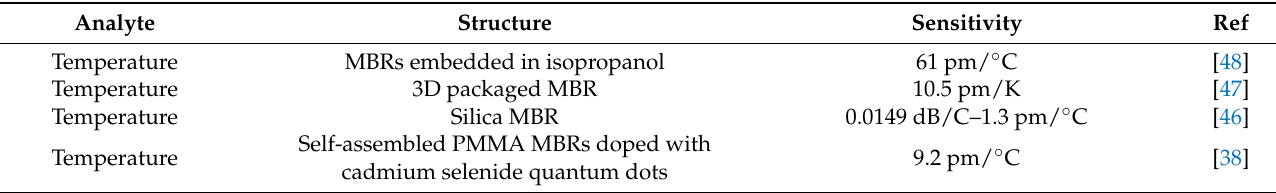
Table 2. Sensing performance of experimental MBR